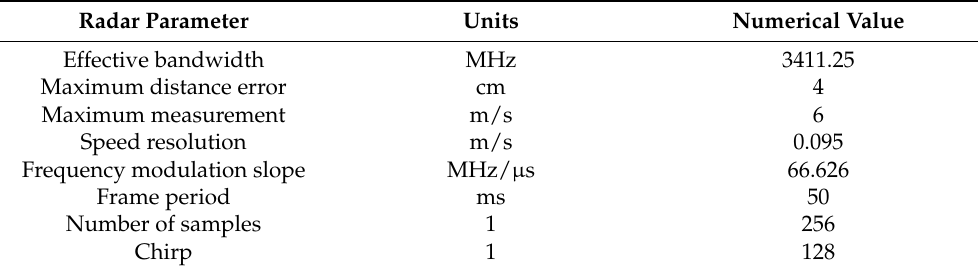
Table 1. Parameter setting for effective driving behavior perception. Radar Parameter